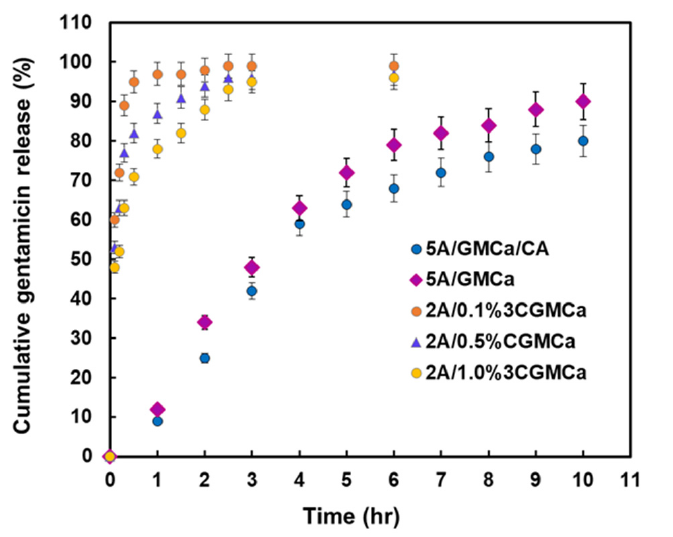
Figure 9. The cumulative release of gentamicin from the beads as a function of immersion time in PBS solution: (top to down) GM-loaded alginate beads crosslinked with citric acid (5A/GMCa/CA), GM-loaded alginate beads (5A/GMCa), and GM-loaded alginate-chitosan beads (2A/x%3CGMCa, x = 0.1, 0.5, 1.0).